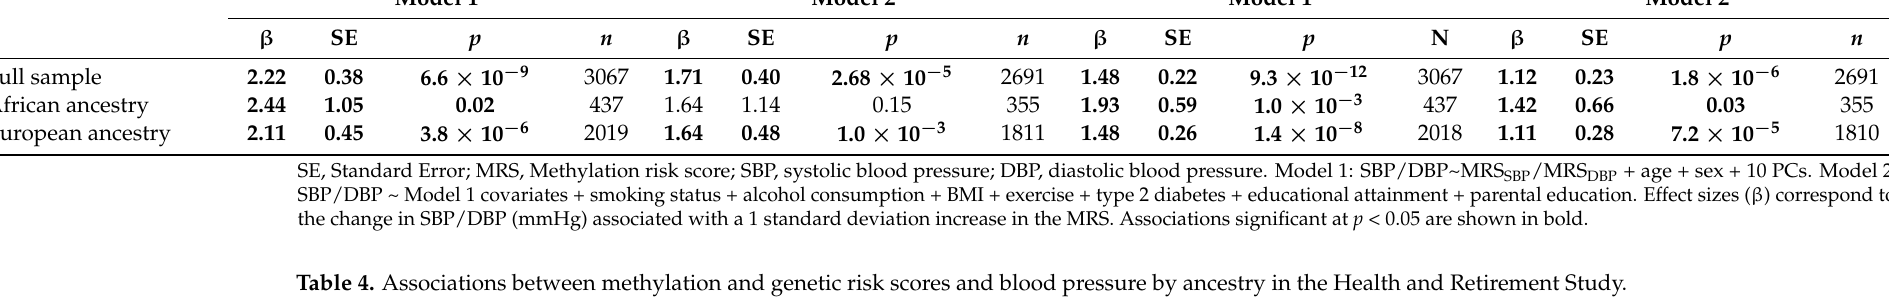
Table 4. Associations between methylation and genetic risk scores and blood pressure by ancestry in the Health and Retirement Study. Systolic Blood